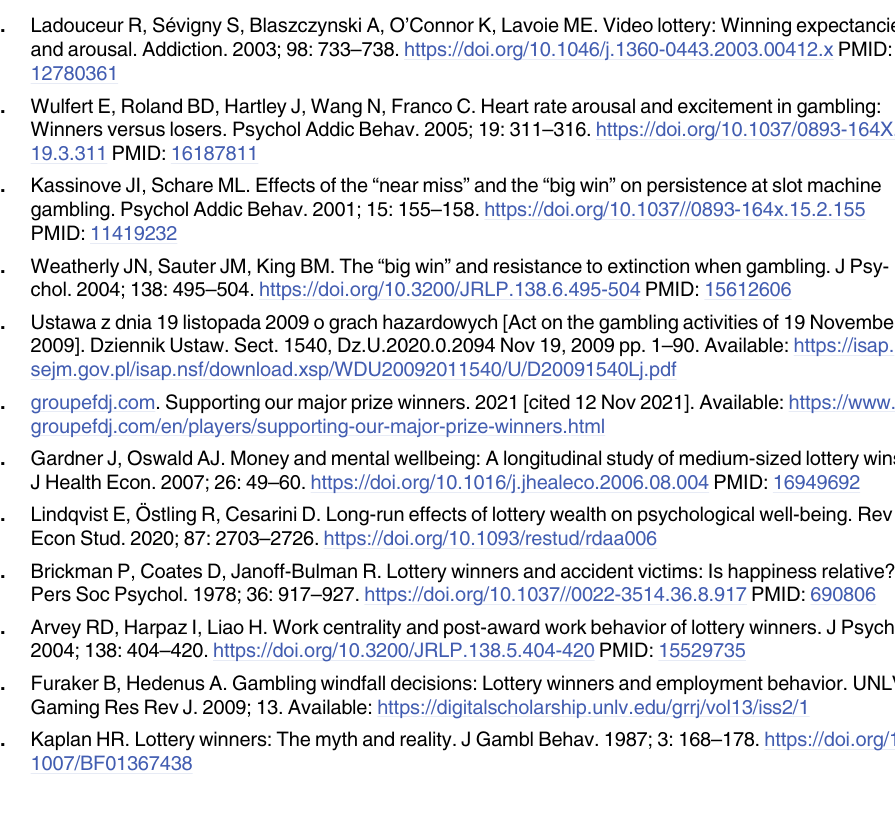
S4 Table. Logistic regression: The final common model and simple effects